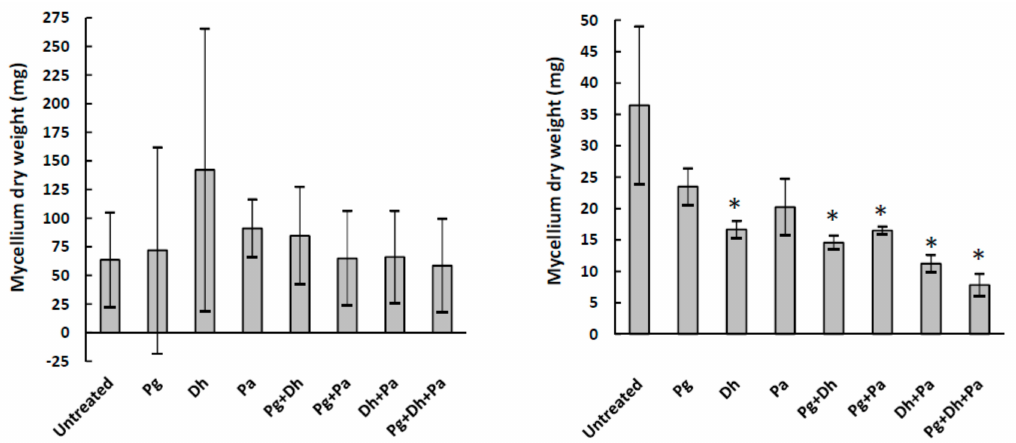
Figure 1. Mycelium dry weight of A. parasiticus cultured in yeast extract sucrose broth (left) and calcium-enriched yeast sucrose broth (right) for 15 days with different combinations of biopreservative agents. Pg: PgAFP, Dh: Debaryomyces hansenii , Pa: Pediococcus acidilactici. * Means are